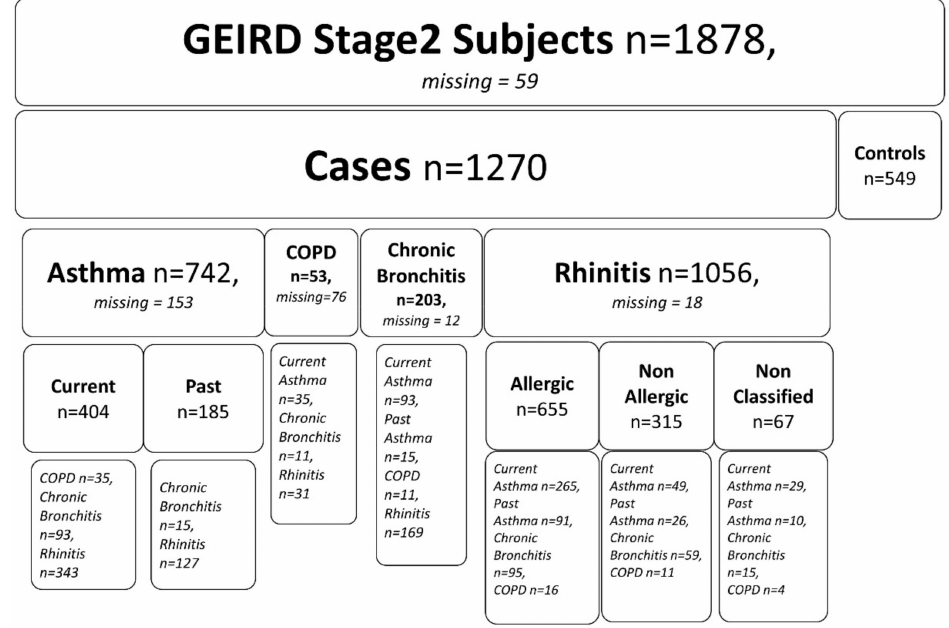
Figure 1. Number of participants in the Gene Environment Interactions in Respiratory Diseases (GEIRD) study of Verona, Pavia, Turin and